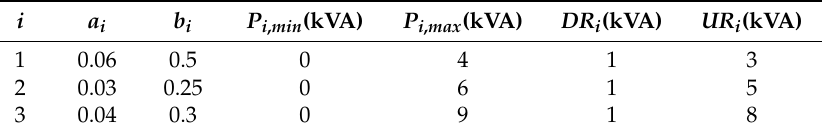
Table 2. Cost coefficients to customers classification and interruptibility limits.